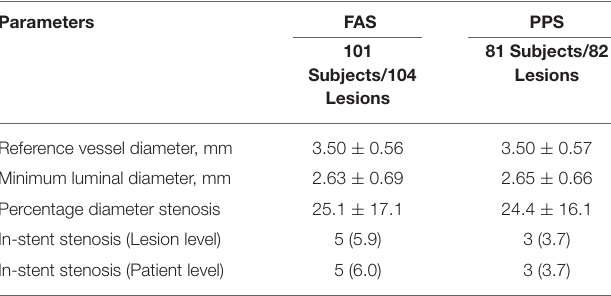
TABLE 2 | 6-month angiographic